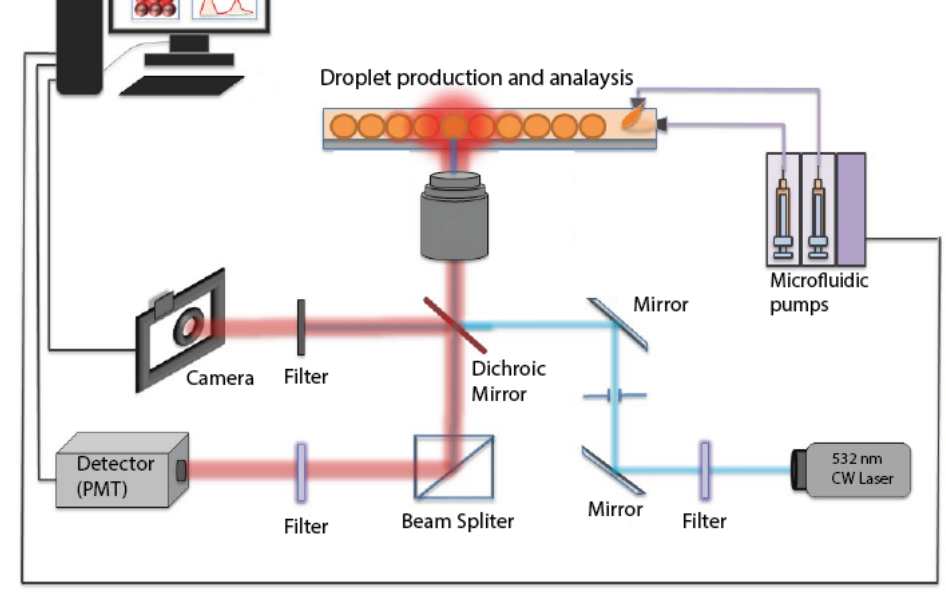
Figure 4. Optofluidic setup used for real-time fluorescence measurements recorded from flowing droplets in the microfluidic